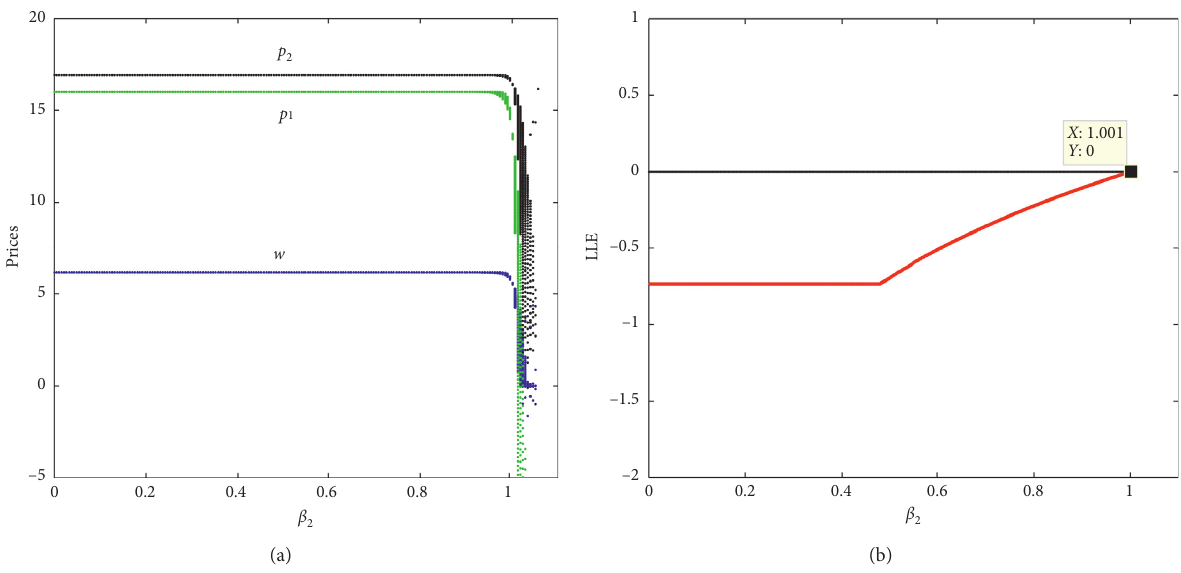
Figure 23: The behavior of dynamic system (25) with respect to β